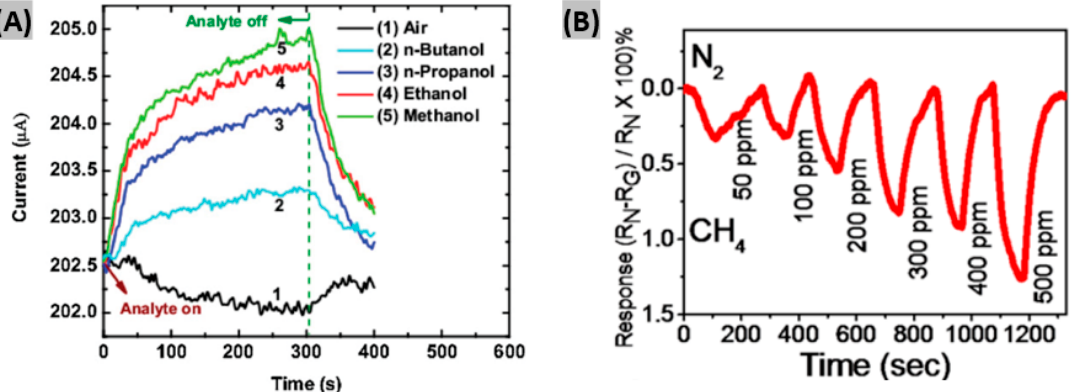
Figure 2. ( A ) Variation of sensor currents of the SnO 2 functionalized GaN NW device toward 500 ppm of various alcohols. Figure adapted with permission from [47], Copyright 2012 Elsevier. ( B ) Sensor responses of GaN NW at the exposure of CH 4 gas concentrations ranging from 50 ppm to 500 ppm. Figure adapted with permission from [51], Copyright 2015 American Chemical Society.